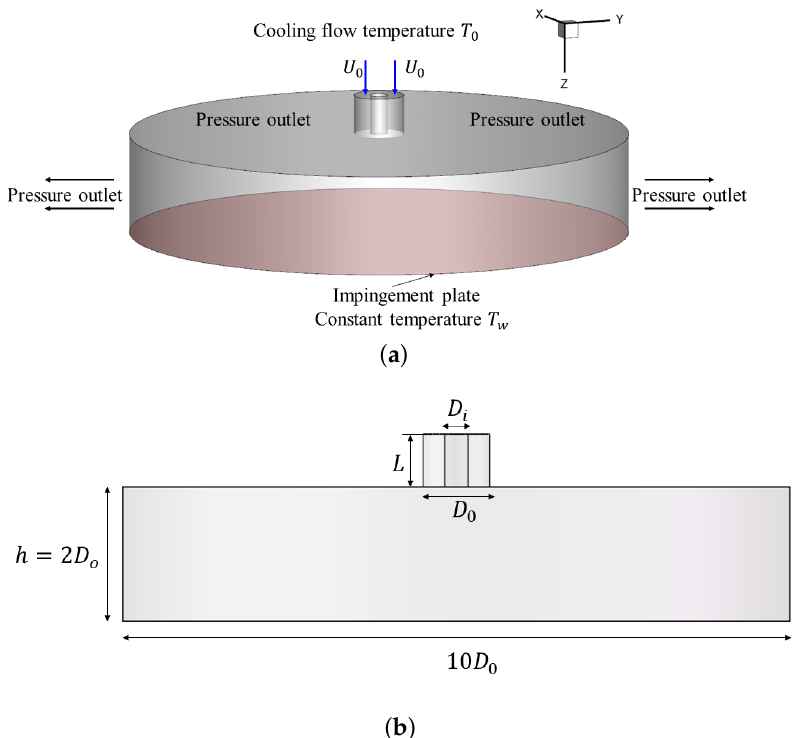
Figure 2. Schematic of ( a ) calculation domain and ( b ) geometric information. The uniform velocity U 0 is set at the jet inlet and the flow moves parallel to the jet axis. The Reynolds number based on the inlet velocity and the outer diameter is Re = ρ U 0 D 0 20,000. Pressure outlet condition with ambient pressure is applied on the side and the